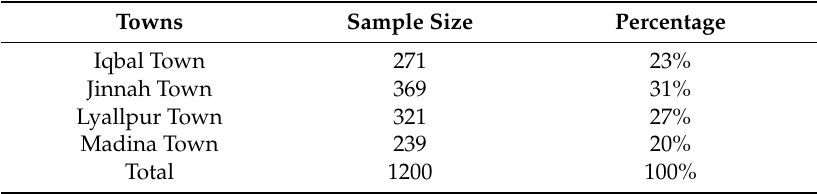
Table 1. Description of survey sampling